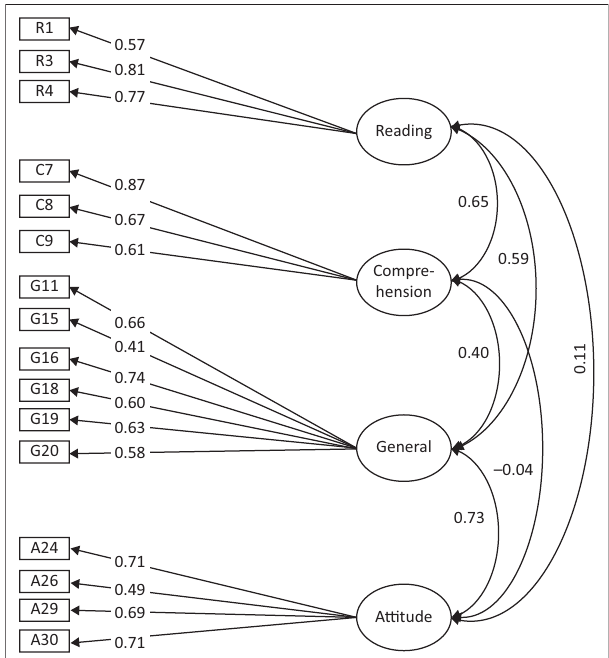
FIGURE 1: Four-dimensional model of the four components of the Teachers Awareness Questionnaire.